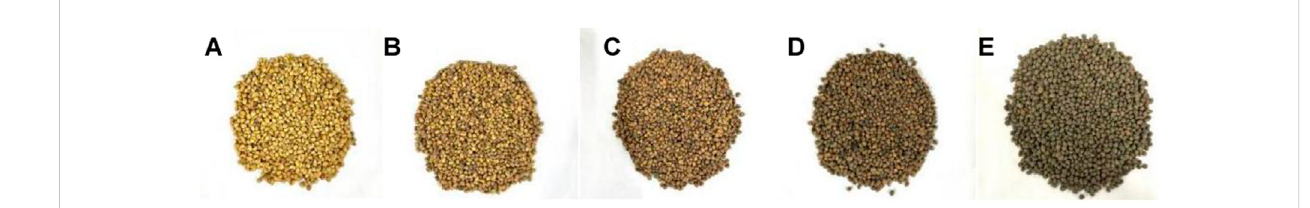
FIGURE 5 RawPSsampleandvariousstir-friedPSsamples. (A) :rawsample; (B) and (C) :samplesfriedat120 ° Cfor3 minand13 min; (D) and (E) :samplesfriedat 150 ° C for 3 min and 13 min.